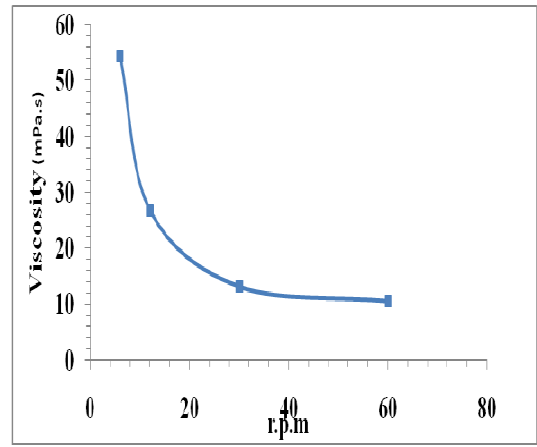
Figure (4): Viscosity versus rpm at 37 0 C for F 5